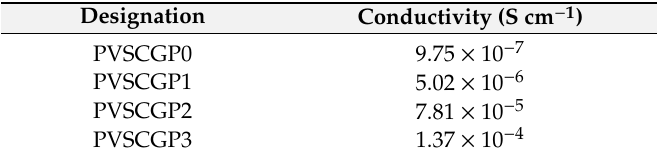
Table 2. DC conductivity for the electrolyte systems at room